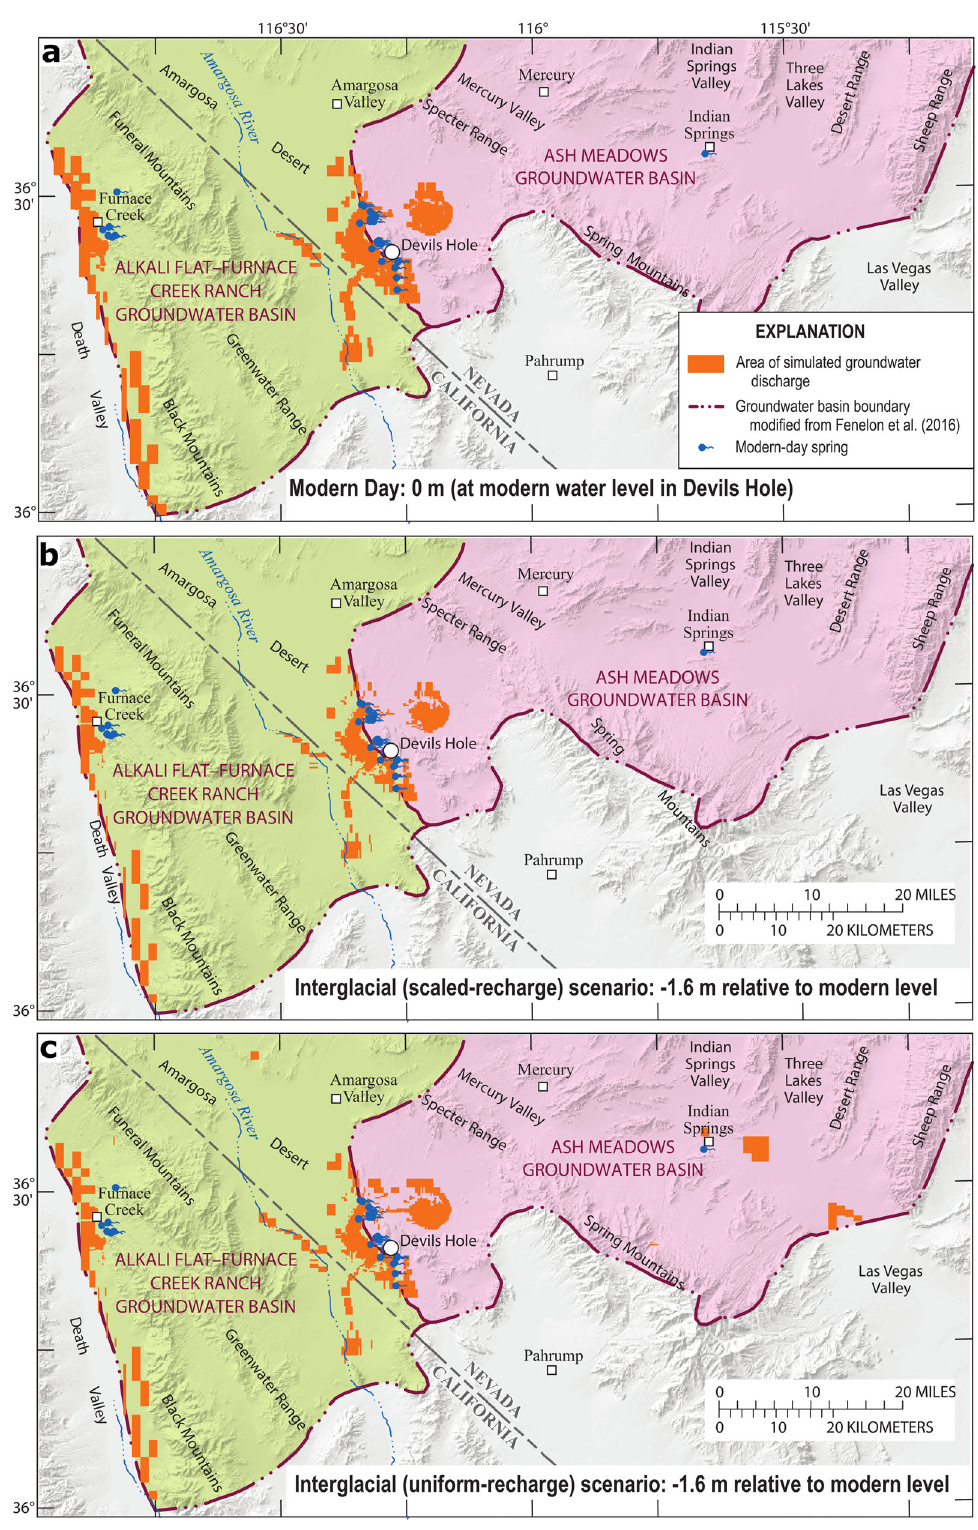
Fig. 5 Groundwater-discharge areas for modern-day and interglacial condition. Simulated groundwater-discharge areas for modern-day ( a ), interglacial (scaled-recharge; b ), and interglacial (uniform recharge; c ) changed. The uniform-recharge approach assumes that valley during the last 350,000 years (i.e., recharge on valley fl oors is fl oors receive a larger recharge contribution in wetter periods. small-to-negligible compared to highland areas). Conversely, the scaled-recharge approach assumes that the ratio A qualitative evaluation of simulated paleodischarge areas in of the spatial recharge distribution has remained unchanged the peak glacial ( + 9.5 m r.m.w.t.) scenarios (Fig. 4b, c) indicates